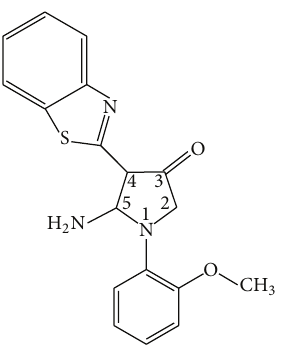
Figure 1: 5-amyno-4-(1,3-benzothyazol-2-yl)-1-(3-methoxyphen- yl)-1,2-dihydro-3H-pyrrol-3-one (D1) structural